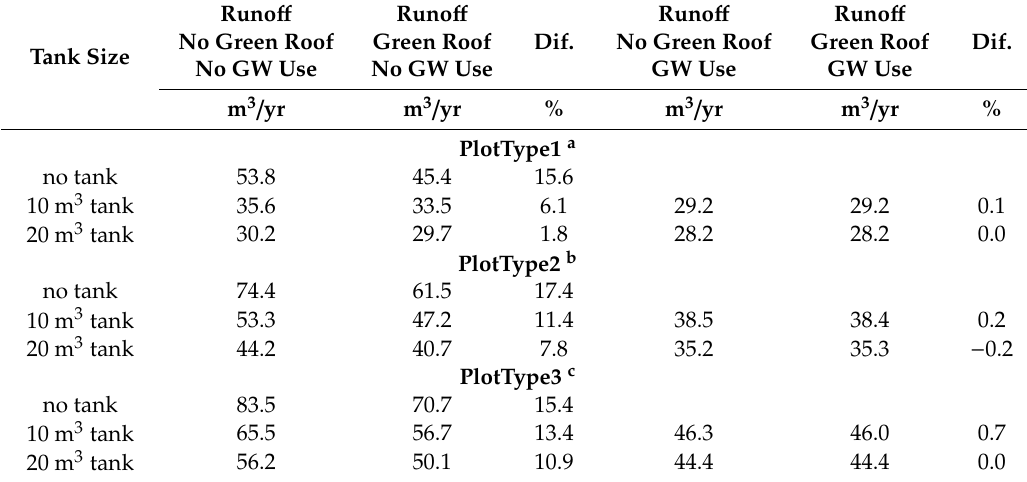
Table 3. Average stormwater runo ff from the three residential plot types with and without green roof, indoor greywater (GW) use and storage tank for 1980–2010; Dif. is the percentage di ff erence between the case with and without green roof.